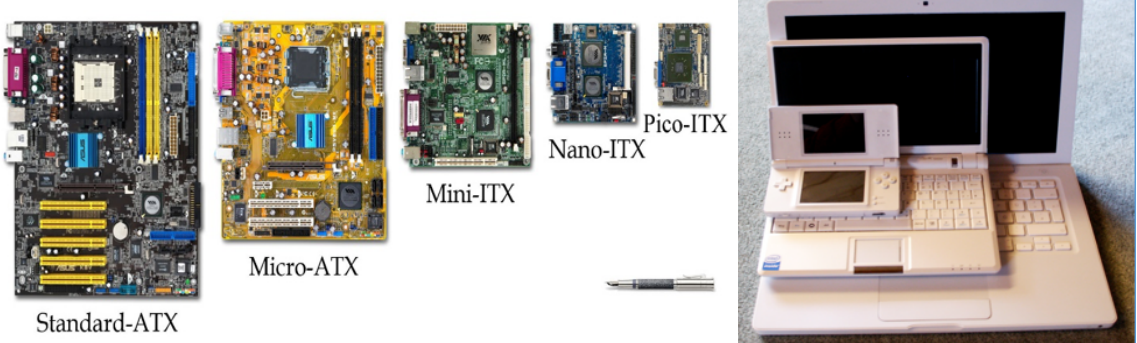
Fig. 4 . Advanced R&D products and components (structures 15 ) are essential but not